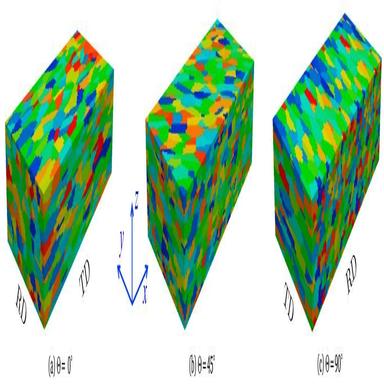
Representative Volume Elements (RVEs) of size = 160 80 40 × × with 500 randomly distributed grains used for uniaxial tensile tests along different loading directions characterized by angle , x is the loading direction, z is the (sheet) normal direction. Figure adopted from with permission from Elsevier.